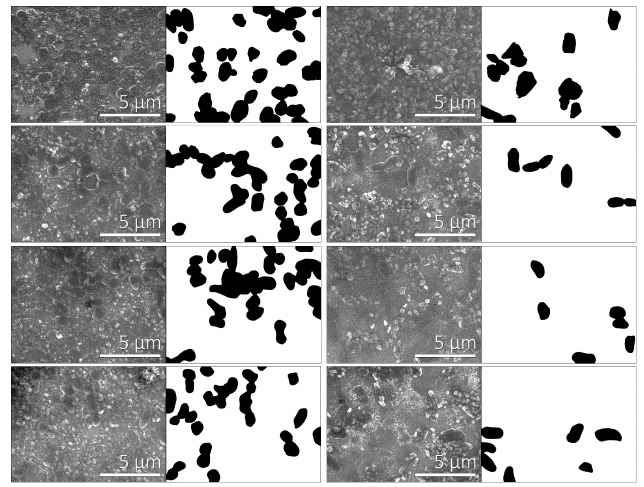
Figure 5. Qualitative analysis of SEM images at 10000× magnification. Column 1: Bacteria adhered on the positive polyelectrolyte layer (SiO 2 plates with five polyelectrolyte layers); column 2: Black and white pictures of adherent bacteria on SiO 2 plates that were covered with five layers. The first picture had 31.4% of the surface covered with bacteria, the second 25.3%, the third 25.9%, and the fourth picture 19.5%; column 3: Adherent bacteria on the negative polyelectrolyte layer (SiO 2 plates with six polyelectrolyte layers); column 4: Black and white pictures of adherent bacteria on SiO 2 plates that were covered with five PEMs. The first picture had 14% of the surface covered with bacteria, the second 6.1%, the third 6.4%, and the fourth picture 7.3%.